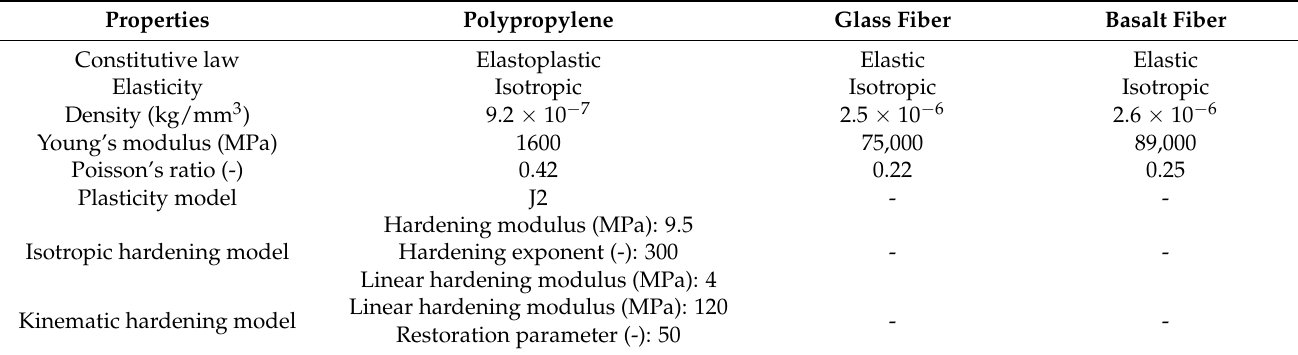
Table 1. Estimated Digimat-MF material